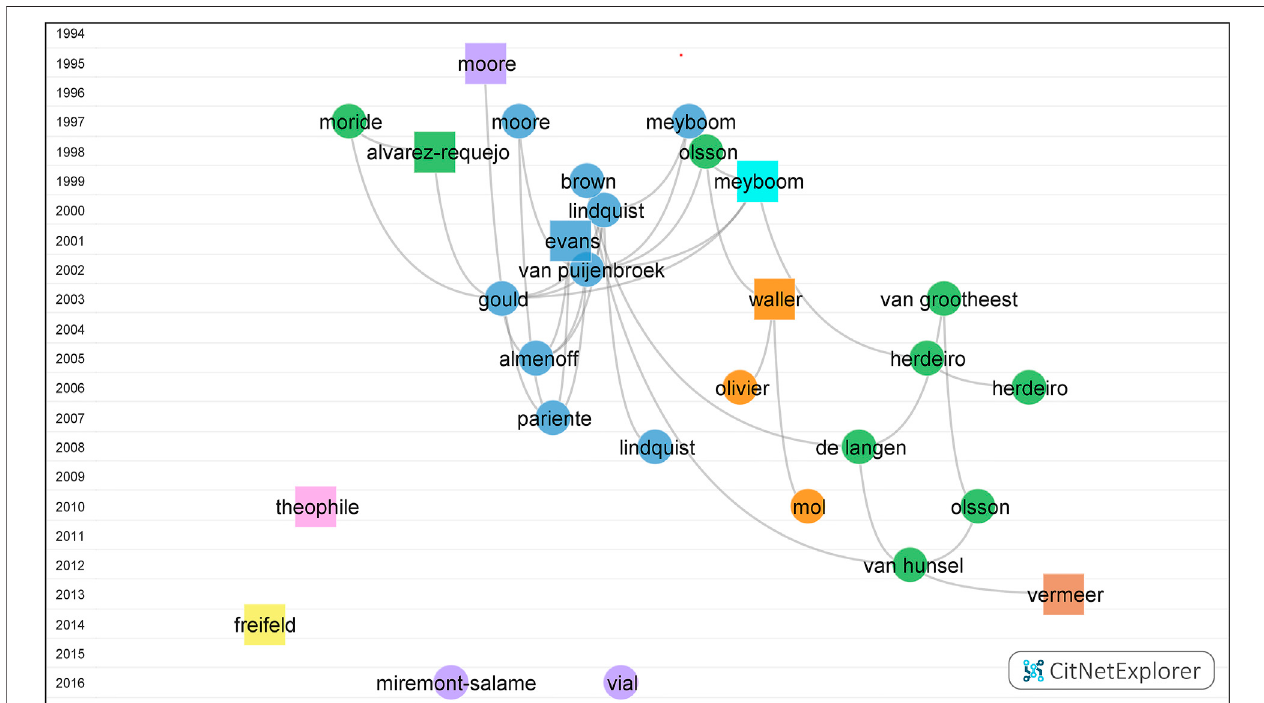
FIGURE 3 | Documents Citation Network Visualization on pharmacovigilance from 1974 to 2021. The vertical axis coordinates indicate the publication year. Each dot/square indicates an article which is labeled with the last name of the fi rst author. Each color marks a cluster. Group I to group VIII, in turn, were colored blue, green, purple,orange, yellow,brown,pinkandcyan,respectively.Thecurvedlineannotatesthecitationrelation.Thesquarerepresentsthepublicationwiththehighestcitation score in each cluster.